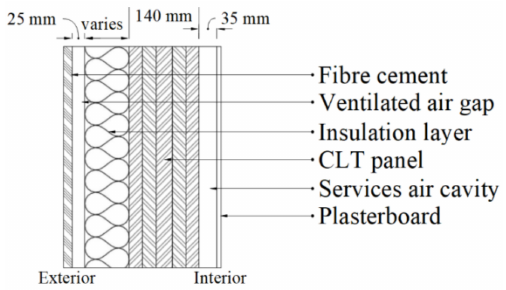
Figure 4. Cross-section of materials used in wall